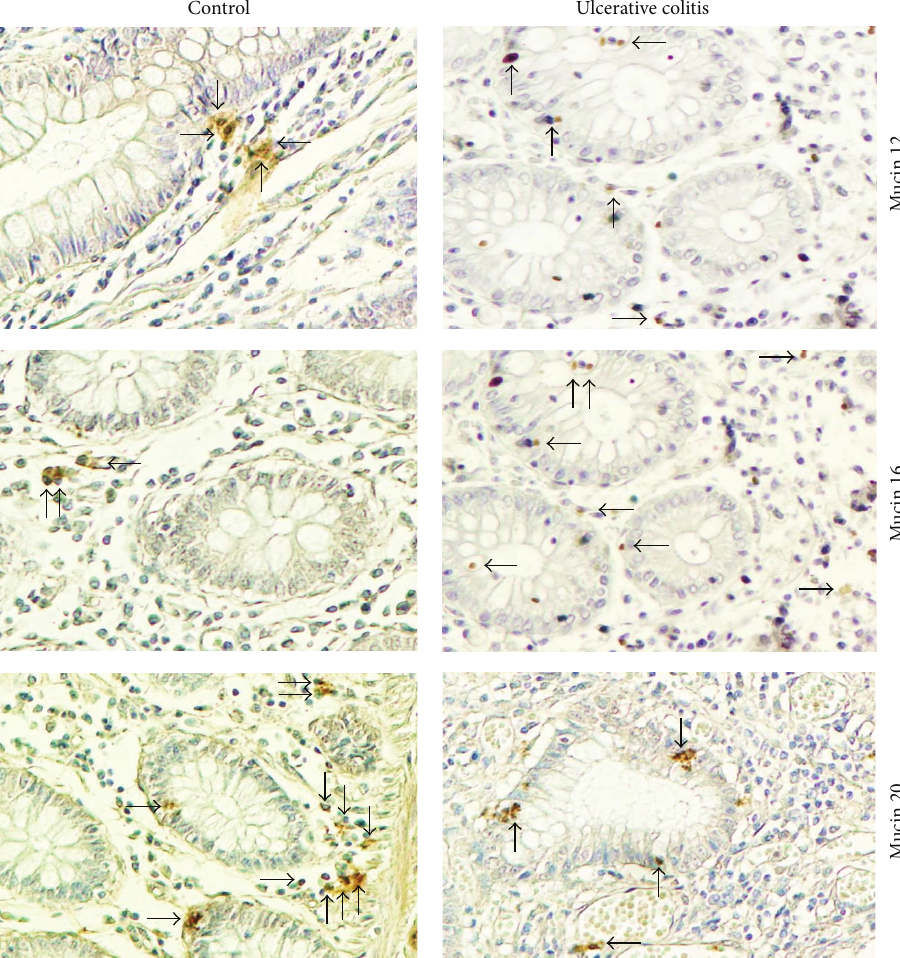
Figure 3: MUC12, MUC16, and MUC20—expressing cells in colonic tissue from patients with ulcerative colitis. Representative immunoperoxidase analysis in noninflamed colonic tissue ( 𝑁 = 10 ) (left panel) and active ulcerative colitis ( 𝑁 = 10 ) (right panel). Arrows depict immunoreactive cells in mucosa, submucosa, muscular, and adventitia layers. Original magnification was ×